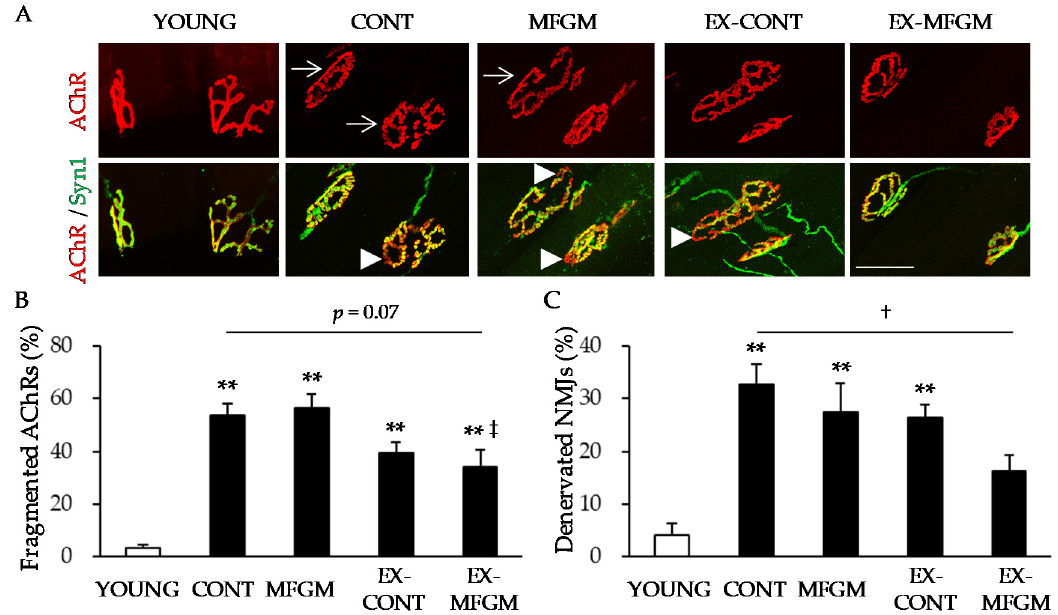
Figure 3. The effect of MFGM supplementation with exercise from a young age on age-related NMJ alterations. ( A ) Repre- sentative NMJ images at 6 months old (YOUNG) and 23 months old (CONT, MFGM, EX-CONT, EX-MFGM) are shown. Postsynaptic AChRs were stained with fBTX (red), and presynaptic nerve terminals were stained with antibodies against synapsin I (green). Arrows show fragmented AChRs, arrowheads denervated NMJs. Scale bar: 50 µm. The percentages of fragmented AChRs ( B ) and denervated NMJs ( C ) were determined. Values are presented as the mean ± SE ( n = 4–5 in each group). ** p < 0.01 vs. YOUNG group, † p < 0.05 vs. CONT group, ‡ p < 0.05 vs. MFGM diet group by Tukey’s test. AChR,